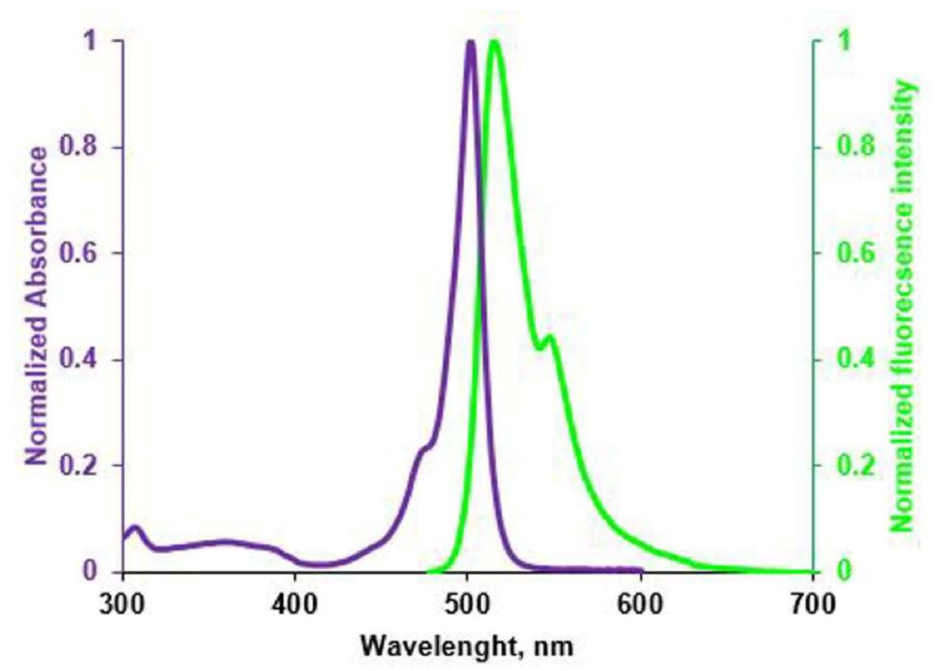
Figure 9. The normalized absorption (purple) and emission spectra (green) of BODIPYmyrt in 1-octanol. The conjugate exhibits a tendency to rapidly penetrate into bacterial, mammalian, and fungal cells and bind with membranes. Strong fluorescence was detected only in BODIPY-treated S. aureus cells, assuming no accumulation of conjugate in the membranes (Figure 10). By contrast, in E. coli , the pronounced green fluorescence was observed on the cell edge suggesting that the combination of myrtenol with BODIPY led to no penetration into the cell. Green fluorescence was also recorded in the cells of C. albicans fungi, while BODIPY was associated mainly with the cell nucleus, and in the threads of F. solani BODIPY, the conjugate was concentrated in the form of rare spots (Figure 10).